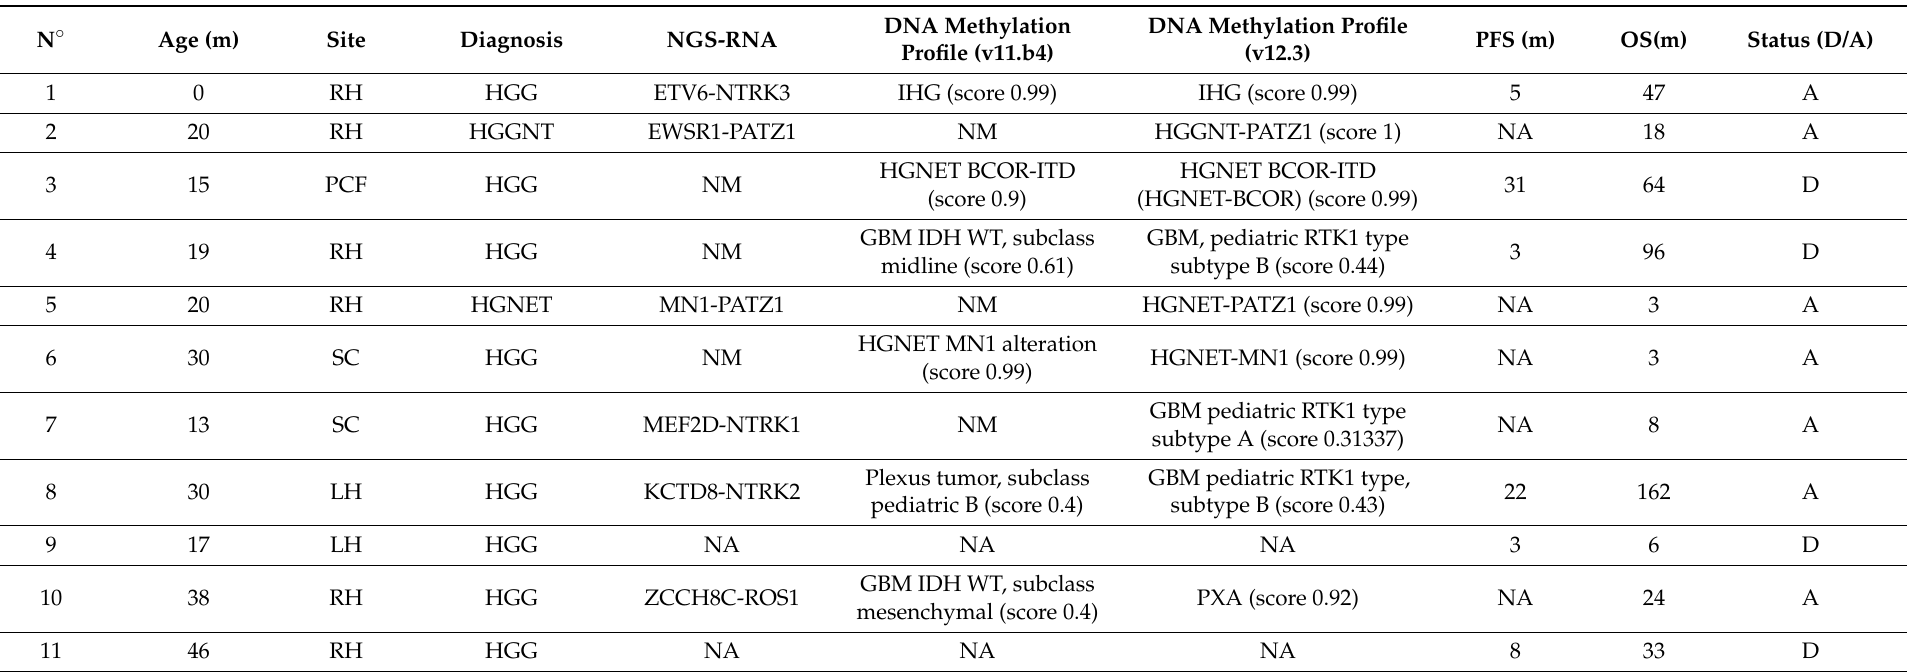
Table 1. Characteristics of